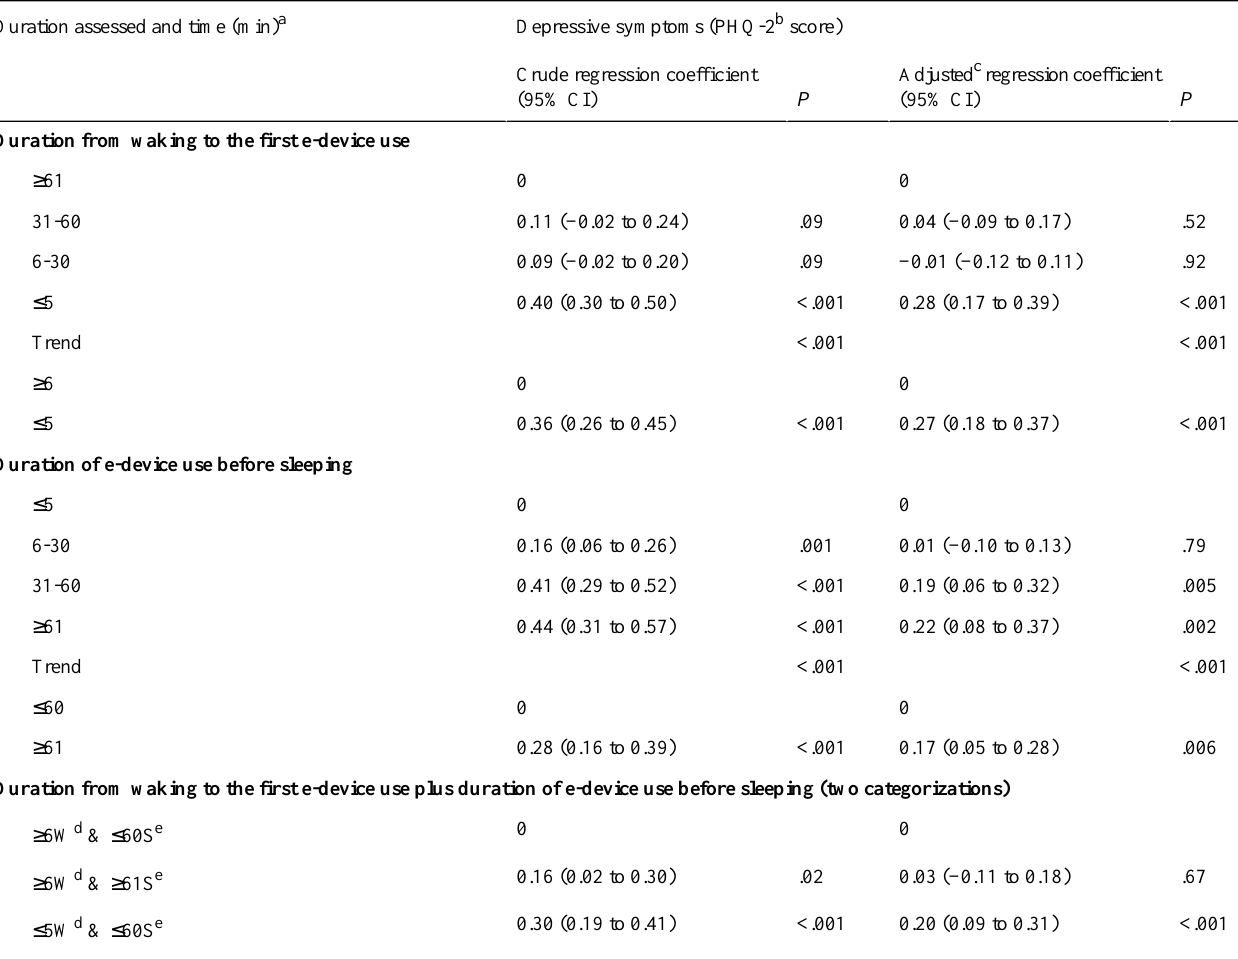
Table 3. Linear regression of depressive symptoms for the duration from waking to the first e-device use and duration of e-device use before